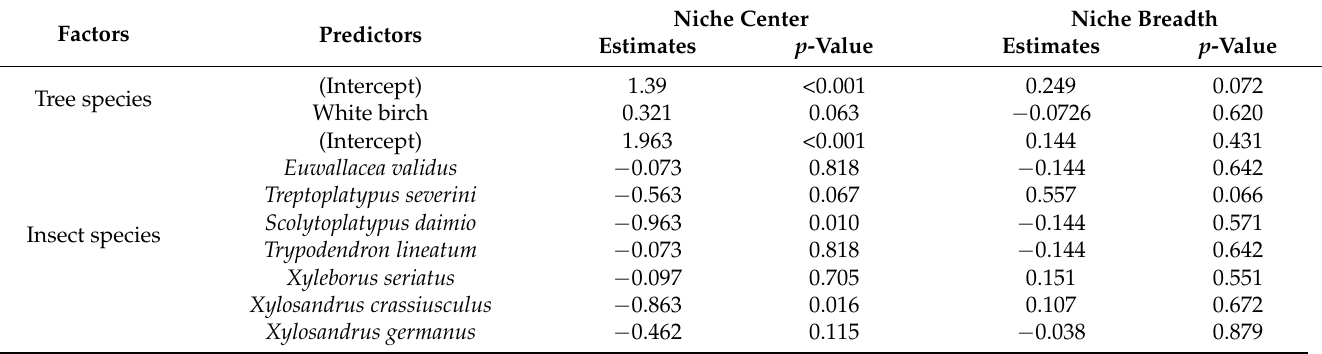
Table 2. Effects of tree species and insect species on the niche center and breath of ambrosia beetles found in alder and white birch logs, analyzed using a generalized linear mixed model. For the tree species effect, alder was used in the base model with the insect species as the random effect. For the insect species effect, Xyleborinus attenuatus was used in the base model with the tree species as the random effect.